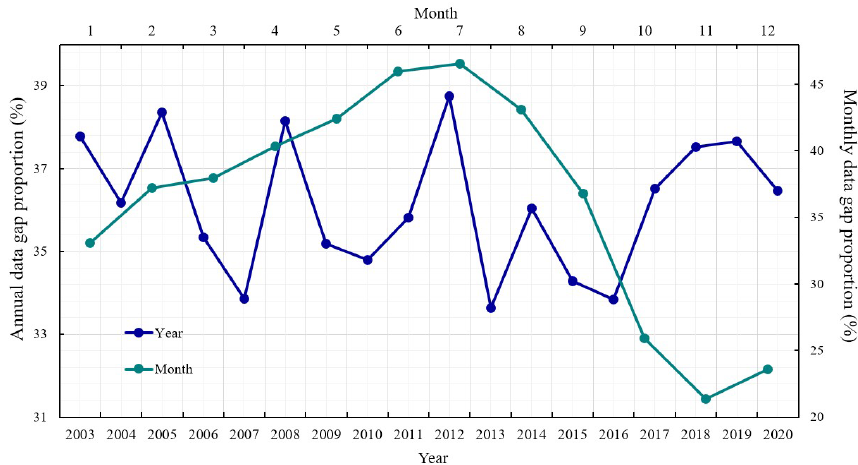
Figure 2. Annual and monthly average proportion of data gaps of original composite MODIS snow products.